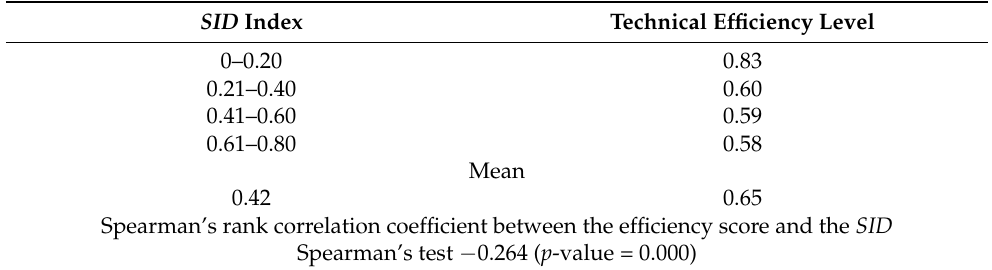
Table 3. Relationship between the crop diversity index ( SID ) and the technical efficiency